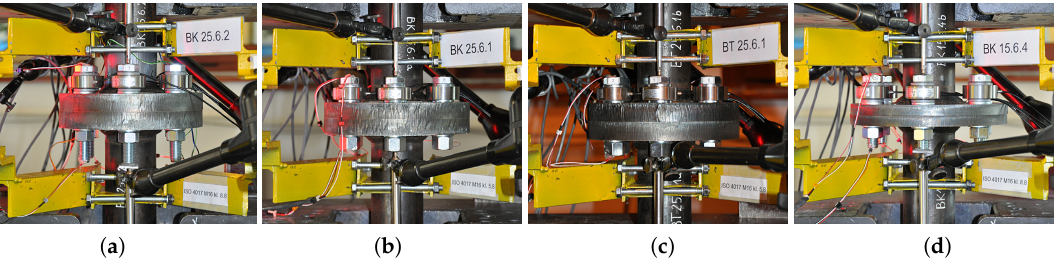
Figure 1. Example of connections subjected to static tests and the elastic wave propagation measurements in bolts: ( a ) P1, ( b ) P2, ( c ) P3, ( d ) P4.